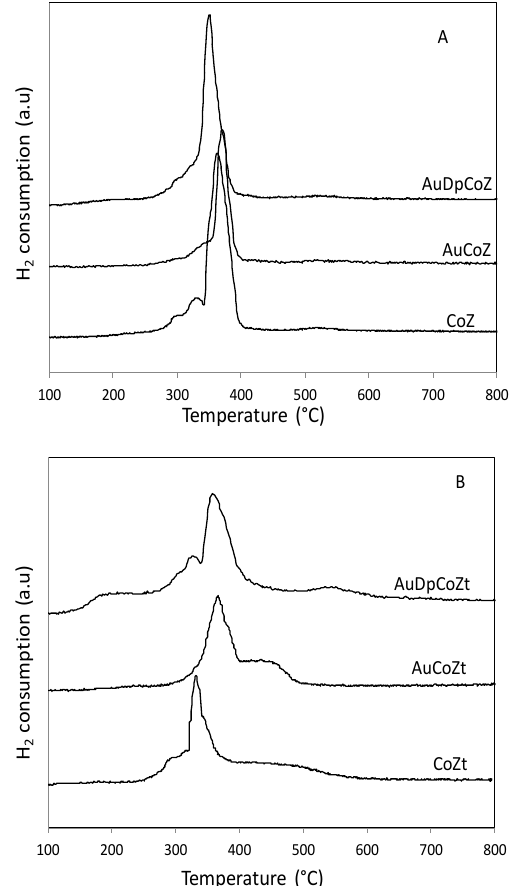
Figure 5. Temperature-programmed reduction diagrams of ( A ) monoclinic zirconia-supported catalysts and ( B) tetragonal zirconia-supported catalysts.